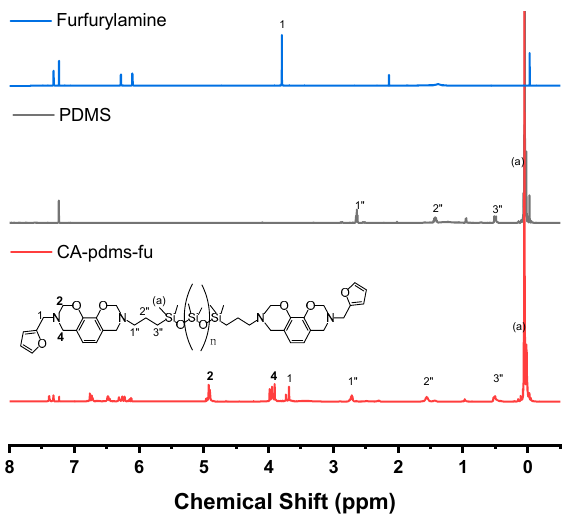
Figure 2. 1 H NMR spectra of CA-pdms-fu in CDCl 3 and its reactants.